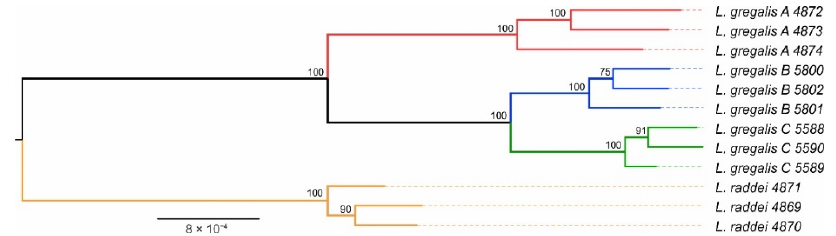
Figure 2. Phylogenetic reconstruction of the narrow-headed vole species complex. Node labels display ML rapid bootstrap support. The names of the specimens contain tissue numbers, see Table S1 for details.